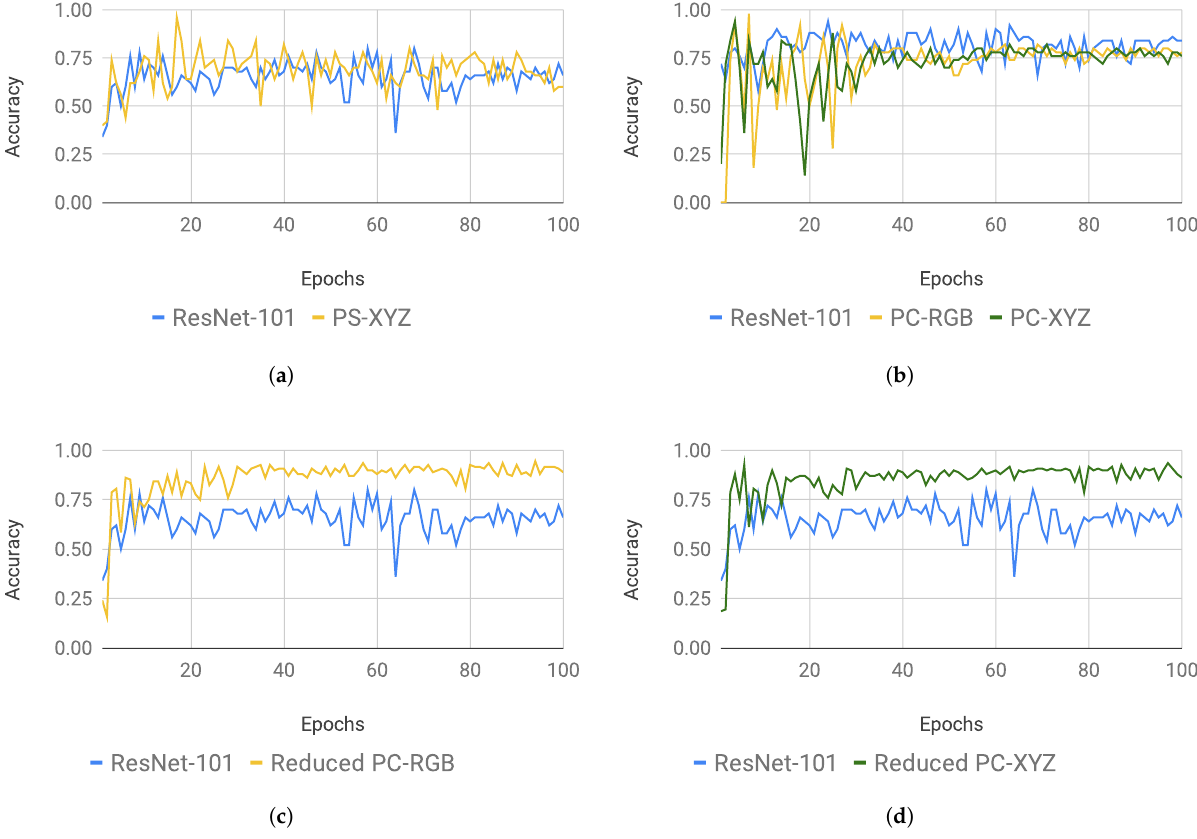
Figure 11. Examples of models that use topological features that achieve accuracy scores higher than those of ResNet-101 in at least some epochs of training. ( a ) Class 1 (melanoma, MEL). ( b ) Class 3 (basal cell carcinoma, BCC). ( c ) Class 3 (basal cell carcinoma, BCC). ( d ) Class 3 (basal cell carcinoma,